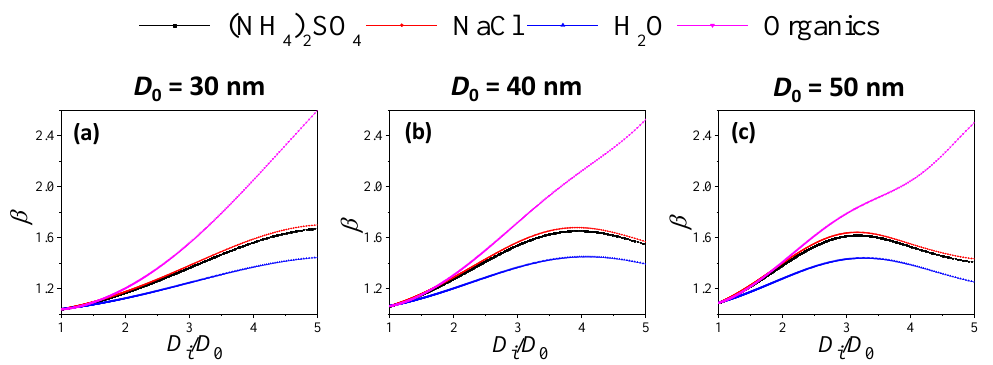
Figure 9. Variation in absorption exponent β of coated soot particles with coating thickness ( D i / D 0 ) for different coating materials (( a ), ( b ), and ( c ): core size D 0 at 30, 40, 50 nm).